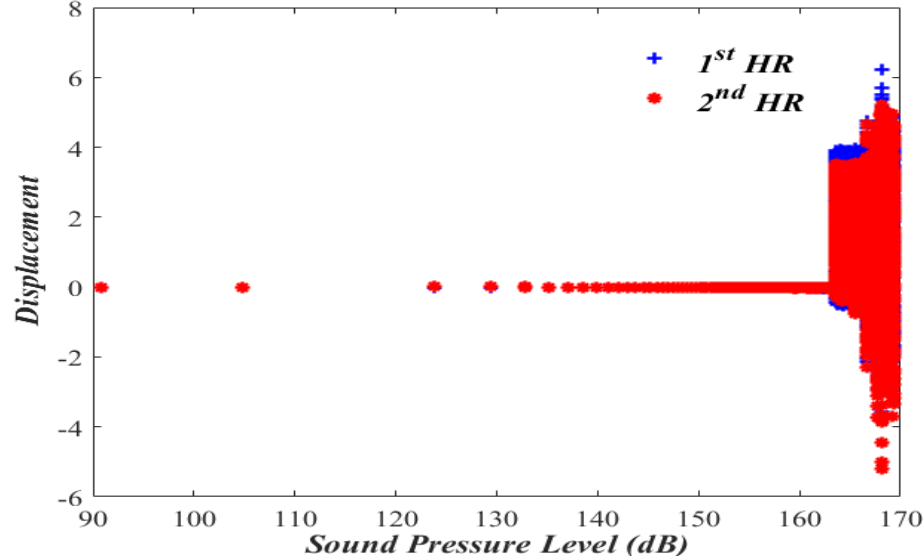
Figure 2. Bifurcation diagram for a nonlinear dual HR (Case I). Note that the 1st and the 2nd HRs have the same displacement before the chaotic response.